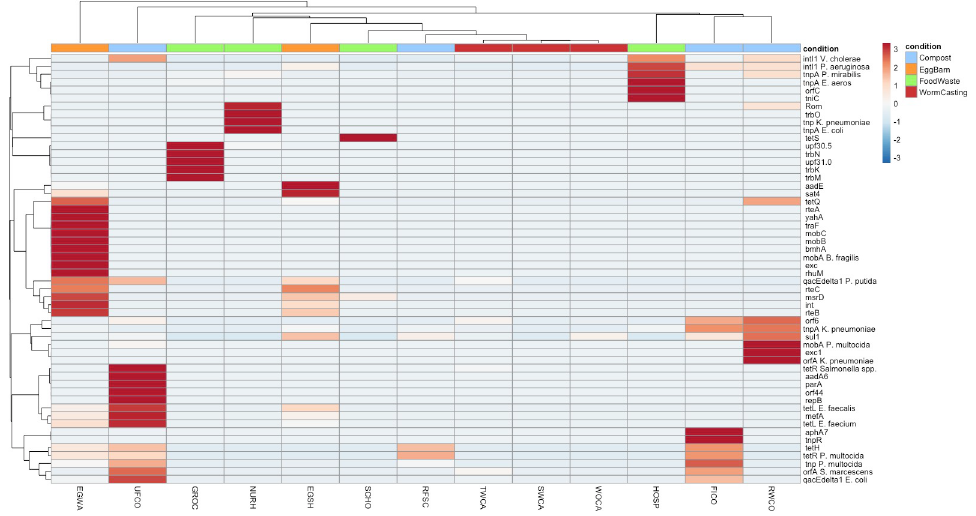
Fig 4. Heatmap displaying the differences in abundance ratio of virulence factors between samples. Heatmap was scaled by row (individual virulence genes) and created using the pheatmap package.